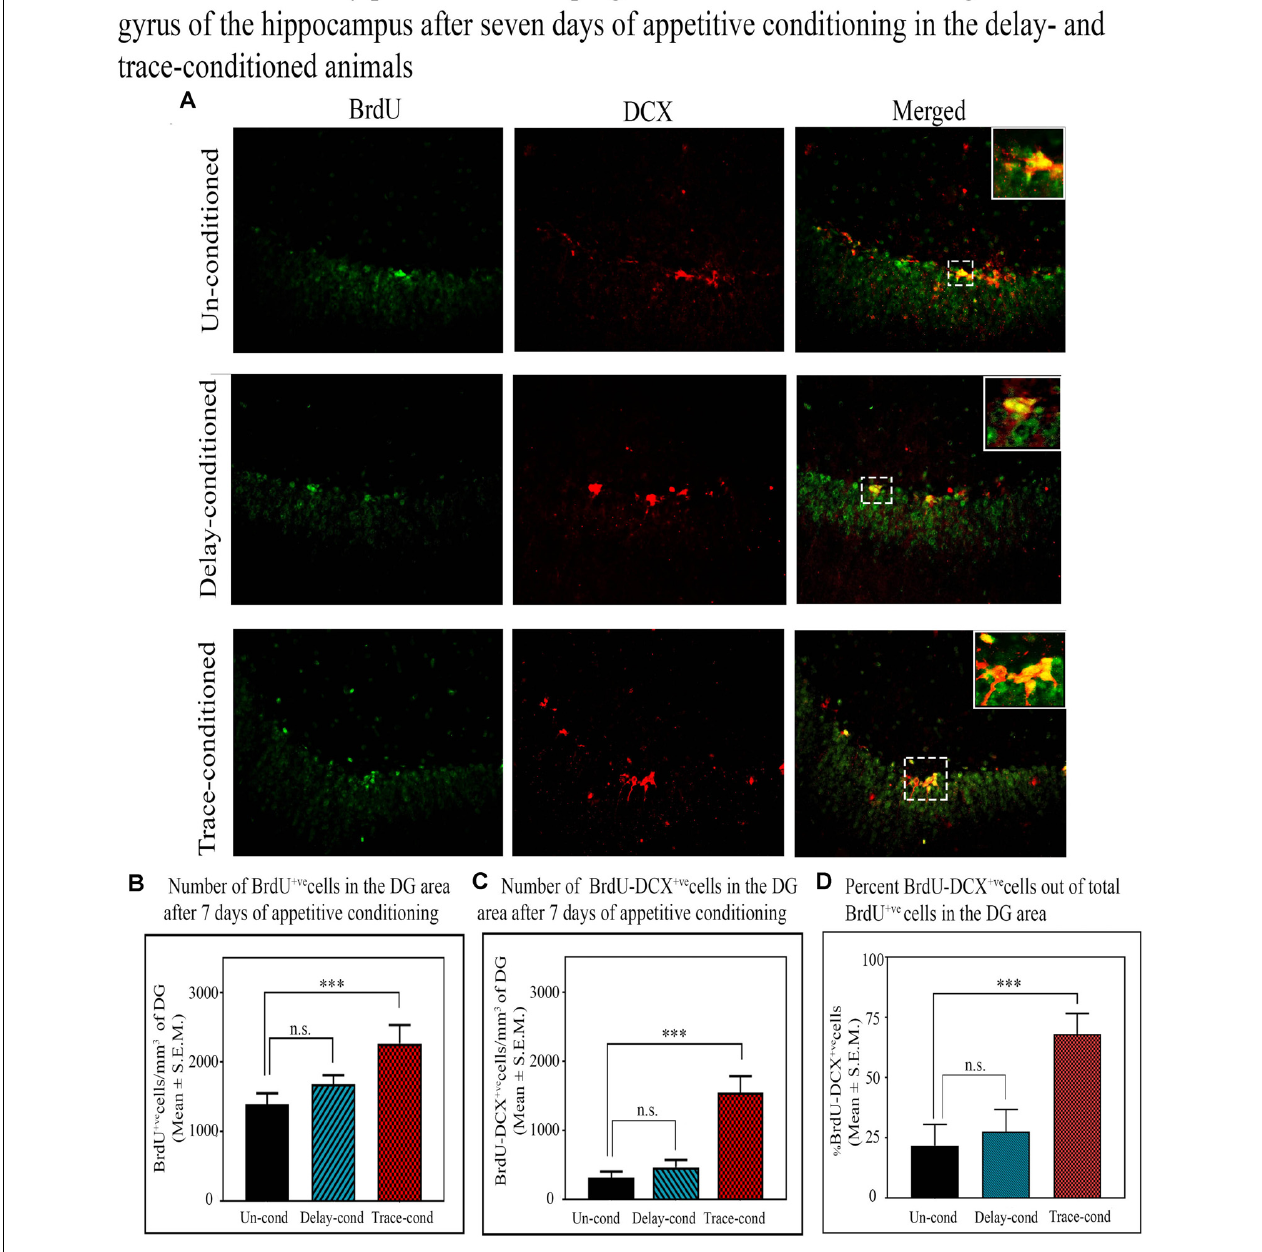
FIGURE 5 | The number of newly proliferated cells progressed towards the neuronal lineage in the DG of the hippocampus after 7 days of appetitive conditioning in the delay- and trace-conditioned animals. (A) Photomicrographs (20X magnification) showing BrdU +ve , DCX +ve , and BrdU +veand DCX +ve double-labeled cells in the DG of the hippocampus in the un-conditioned, delay-conditioned, and trace-conditioned animals. Green dots show the BrdU +ve , red dots show DCX +ve , and yellow and orange dots show BrdU +ve & DCX +ve double-labeled cells. Magnified views of BrdU +ve , DCX +ve , and BrdU +ve & DCX +ve cells are shown in the inset. An average number of (B) BrdU +ve cells/mm 3 of DG (C) double-labeled BrdU +veand DCX +ve cells/mm 3 of DG in the un-conditioned ( n = 6), delay-conditioned ( n = 6) and trace-conditioned ( n = 6) animals. The BrdU +ve cells significantly increased in the trace-conditioned animals ( ∗∗∗ p < 0.001; F (2,17) = 53.33, one-way ANOVA followed by Tukey post hoc ), compared to the un-conditioned control animals. The BrdU +ve cells in the delay-conditioned animals were comparable to the un-conditioned control animals. Similarly, the average number of BrdU +veand DCX +ve double-labeled cells were significantly more in trace-conditioned animals compared to un-conditioned animals ( ∗∗∗ p < 0.001, F (2,17) = 14.90, one-way ANOVA followed by Tukey post hoc ). (D) Out of total BrdU +ve cells, majority cells (67.9%) significantly progressed towards the neuronal lineage in the trace-conditioned animals ( ∗∗∗ p < 0.001, F (2,17) = 27.91, one-way ANOVA followed by Tukey post hoc ). Whereas, the progression of dividing cells in the delay-conditioned towards neuronal lineage were comparable to the un-conditioned animals. n.s., non-significant.